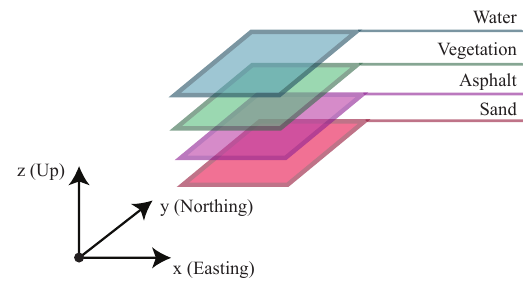
Figure 17. Layered mapping of the classified terrain types.